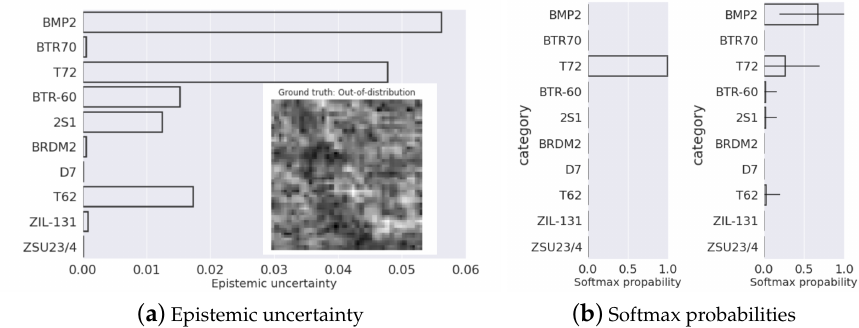
Figure 8. Comparison of CNN and BCNN predictions for an OOD clutter sample. ( a ) Epistemic uncertainty. This was the highest recorded average uncertainty for both in- and out-of-distribution samples. ( b ) Compari- son of CNN and BCNN predictions for OOD. The BCNNs produced five classes with probabilities greater than zero, while the CNN only predicted one class. The OOD input is a clutter